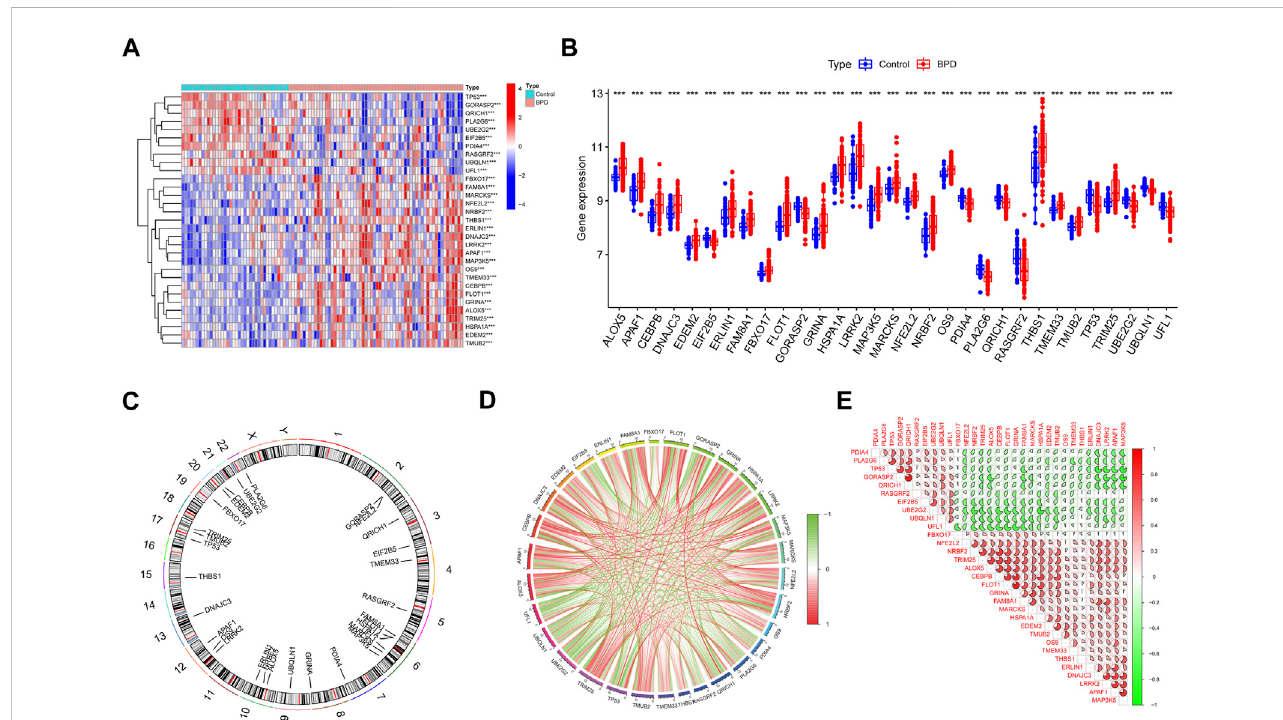
FIGURE 1 Identi fi cation of dysregulated ERSGs in BPD. (A) DE-ERSGs were presented in the heatmap. (B) Boxplots showed the expression of DE-ERSGs between BPD and control samples. *** p < .001. (C) The location of DE-ERSGs on chromosomes. (D) Gene relationship network diagram of DE-ERSGs. (E) Correlation analysis of DE-ERSGs.